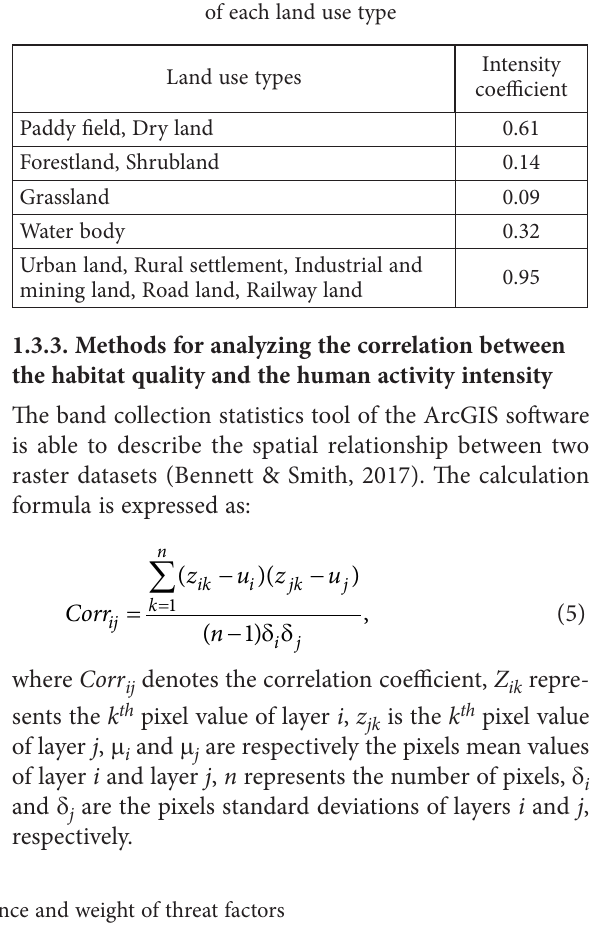
Table 3. Human activity intensity coefficient